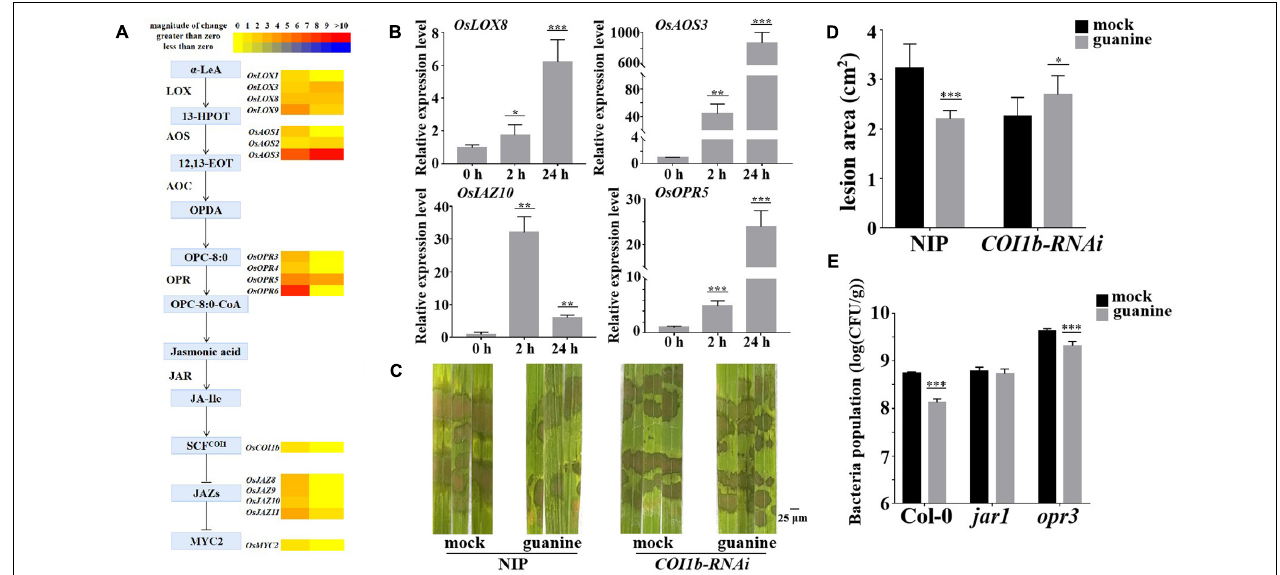
FIGURE 5 | Guanine upregulated the expression of JA signaling pathway genes and enhanced plant disease resistance dependent on the JA signaling pathway. (A) Heatmap of JA-related gene expression after guanine treatment. (B) qRT-PCR for the detection of JA pathway genes OsLOX8 , OsAOS3 , OsOPR5, and OsJAZ10. The horizontal coordinates indicate the time of guanine- and mock-treated rice, and the vertical coordinates indicate the relative gene expression levels of guanine compared to the mock at the same time point. (C) Evaluation of the effect of guanine on COI1b-RNAi against R . solani. (D) Measurement of the lesion area by ImageJ. Lesion area after 3 days of inoculation with R. solani strain YWK196 after guanine treatment in NIP and COI1b-RNAi . Asterisks indicate P < 0.001 (***) and P < 0.05 (*) in Student’s t -test analysis. (E) Inoculation of Pst DC3000 after guanine treatment and bacterial growth in Col-0, jar1 and opr3 after 3 days. Asterisks indicate P < 0.001 (***) in Student’s t -test analysis.